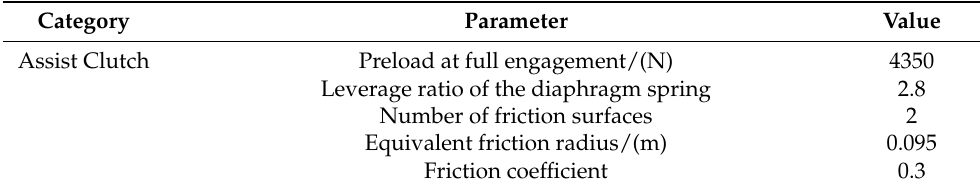
Table 2. Main parameters of the assist